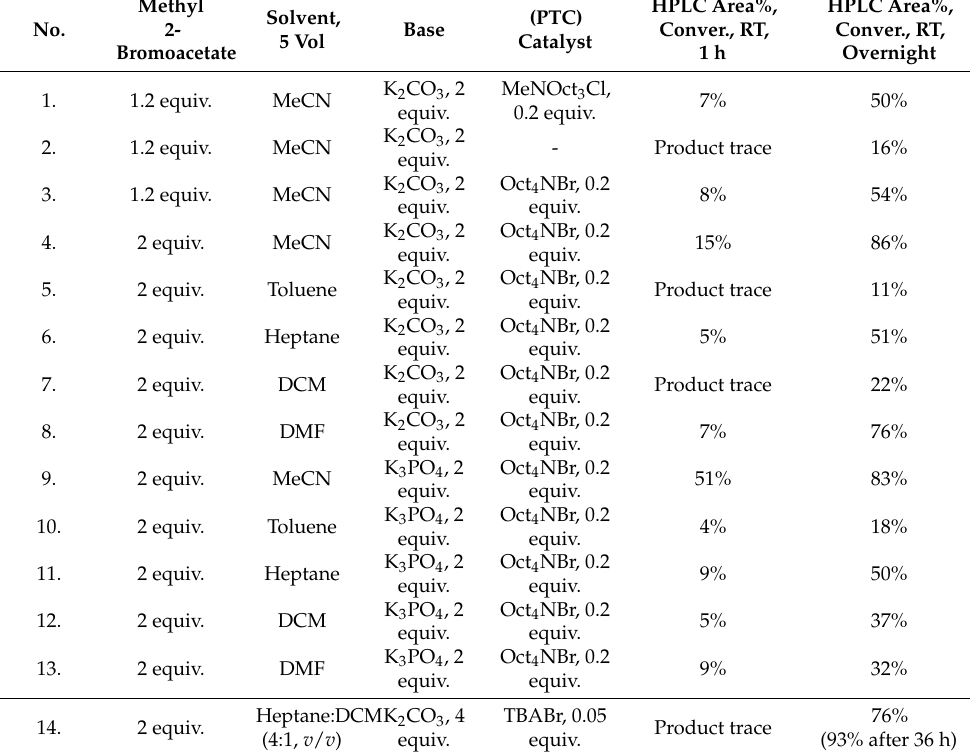
Table 2. Screen for suitable conditions for 2’-OH alkylation of 5-methyl uridine intermediate. Methyl No.